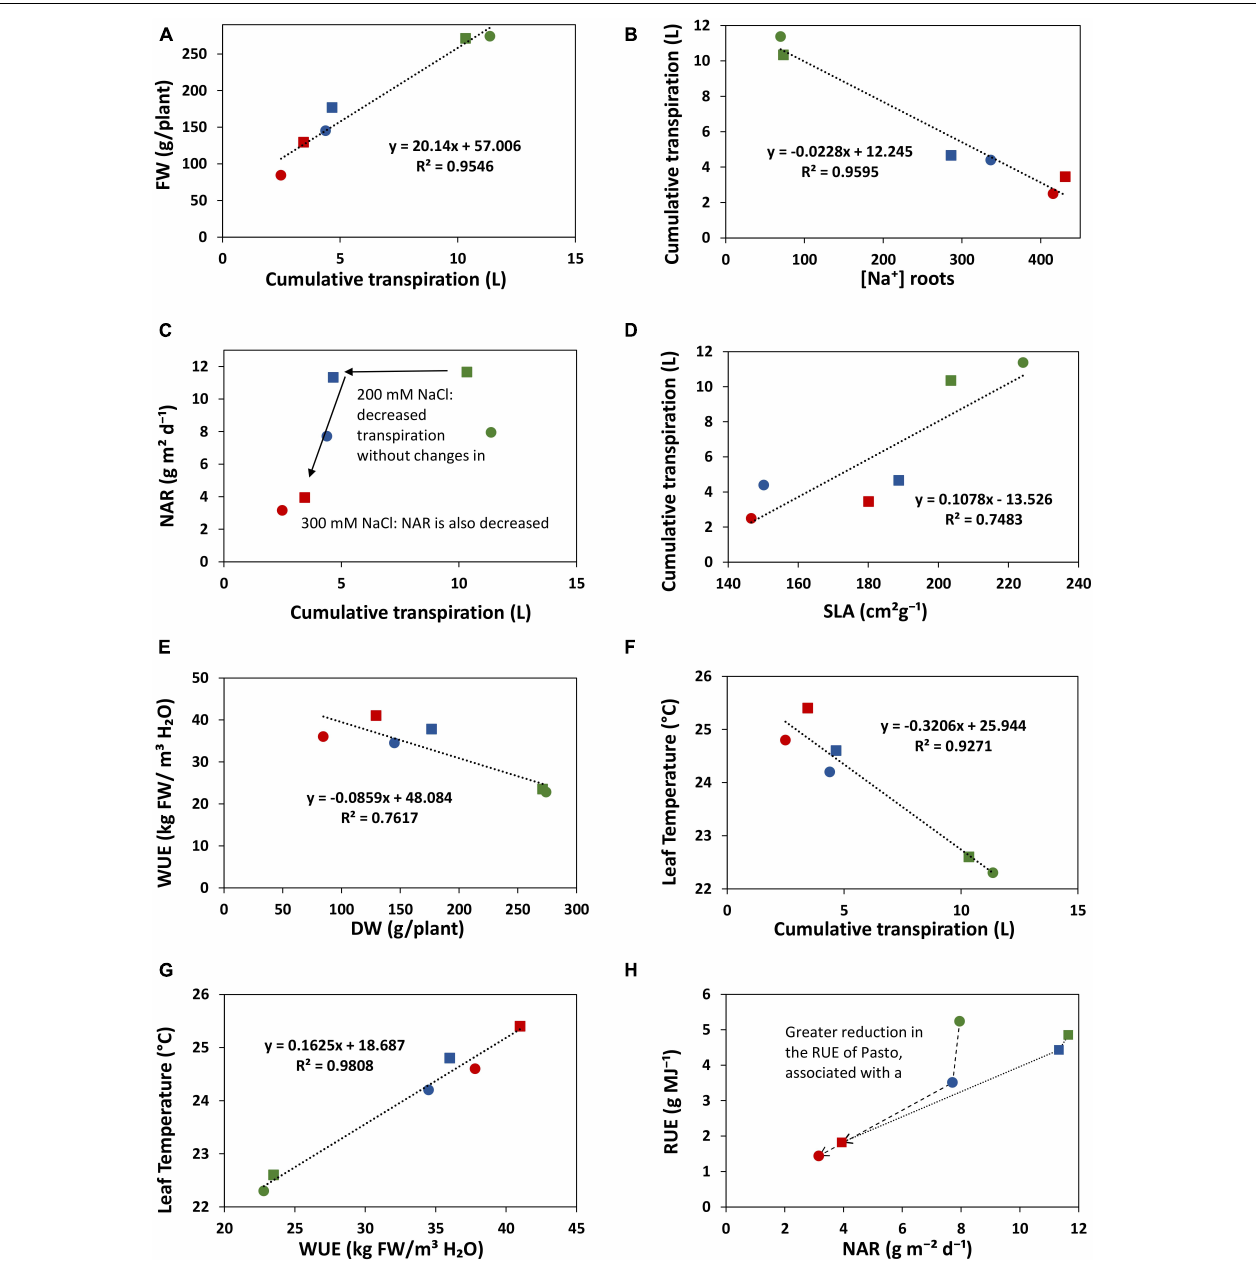
FIGURE 9 | Relations between some of the physiological traits analyzed in this study. The values of selRiobamba are indicated by squares and of Pasto by circles. Level of stress is indicated by color; green: no-salt, blue: 200 mM NaCl, red: 300 mM NaCl. (A) Cumulative transpiration vs. fresh weight of plants. (B) [Na + ] in roots vs. cumulative transpiration of plants. (C) Cumulative transpiration of plants vs. net assimilation rate (NAR). (D) Specific leaf area (SLA) vs. cumulative transpiration of plants. (E) Dry weight of plants vs. water use efficiency. (F) Cumulative transpiration vs. leaf temperature. (G) Water use efficiency vs. leaf temperature. (H) Net assimilation rate (NAR) vs. radiation use efficiency